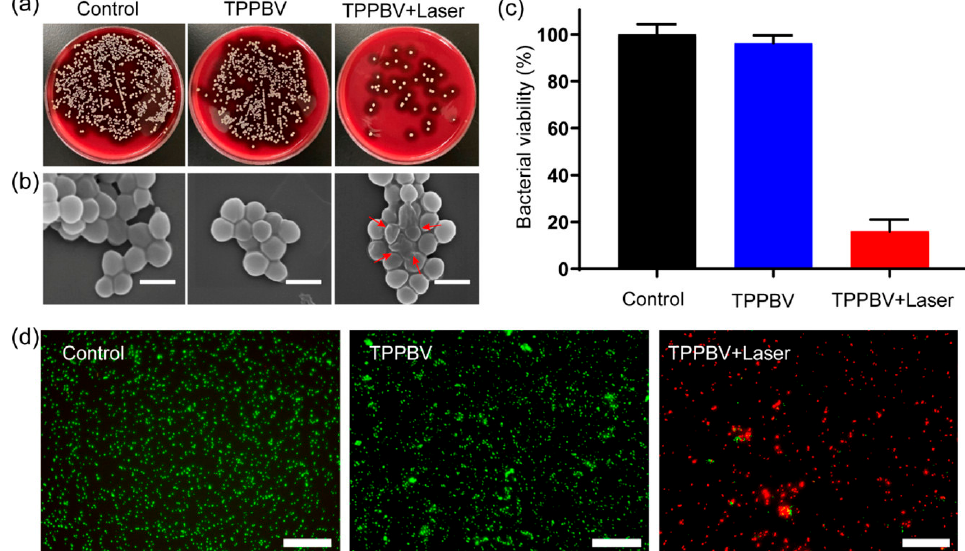
Figure 7. Antibacterial and anti-biofilm effect of photothermal vesicles in vitro. ( a ) Photographs of MRSA bacterial colonies treated with vesicles (500 µ g mL − 1 ), upon laser irradiation (635 nm, 600 mW cm − 2 ) for 10 min and ( b ) corresponding SEM images of the MRSA. Scale bar, 1 µ m. ( c ) Colony-forming unit (CFU) count of MRSA after various treatments. ( d ) Live/dead fluores- cence staining merge pictures of the MRSA biofilm after treatment for 10 min. Scale bar, 75 µ m [107] (Reprinted with permission from